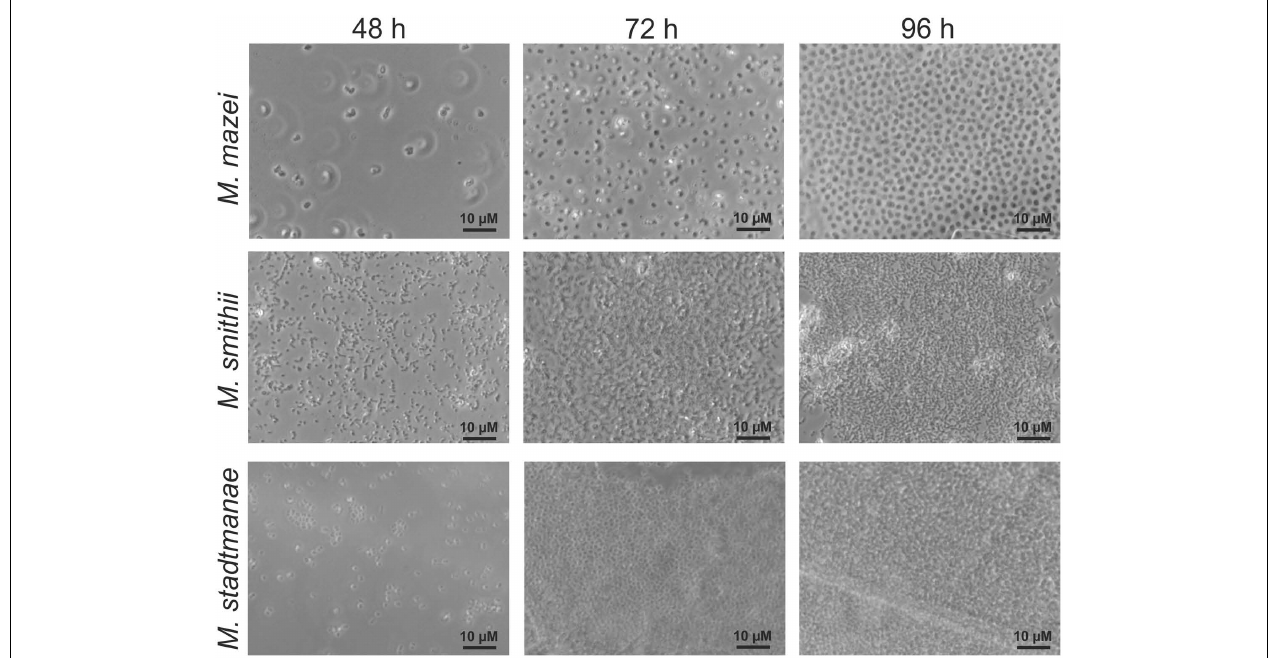
FIGURE 1 | Growth of different methanoarchaea on mica. Methanosarcina mazei , Methanobrevibacter smithii , and Methanosphaera stadtmanae were grown in 3 ml standard medium under an N 2 /CO 2 atmosphere for Methanosarcina mazei or an H 2 /CO 2 gas phase for